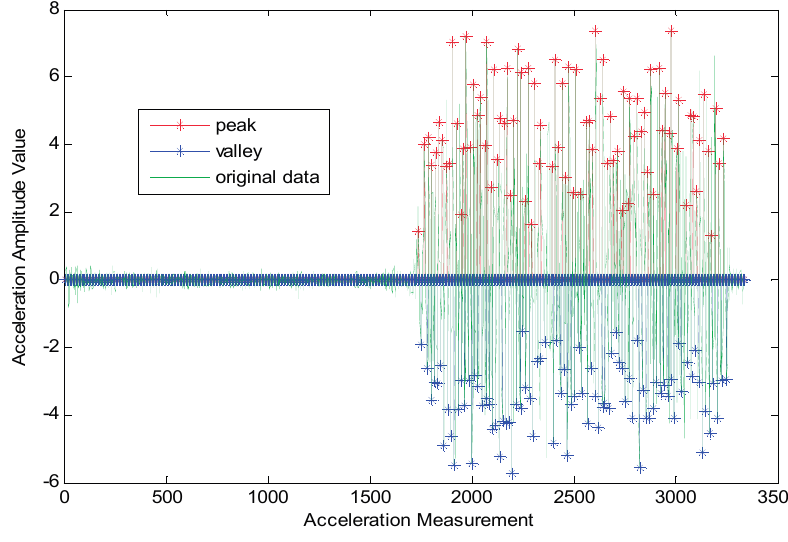
Figure 4. Gait detection based on acceleration data for walking state.